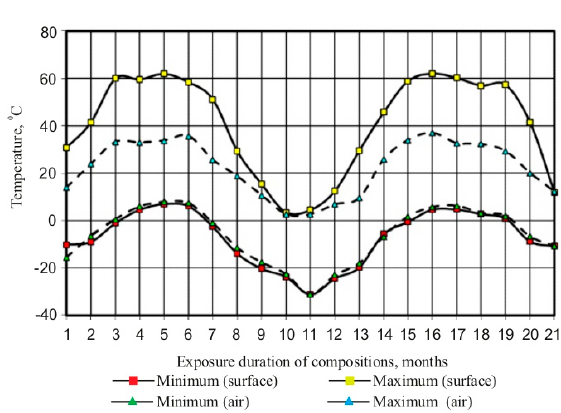
Figure 11. Temperature limits for ambient air and surfaces of epoxy polymer samples.